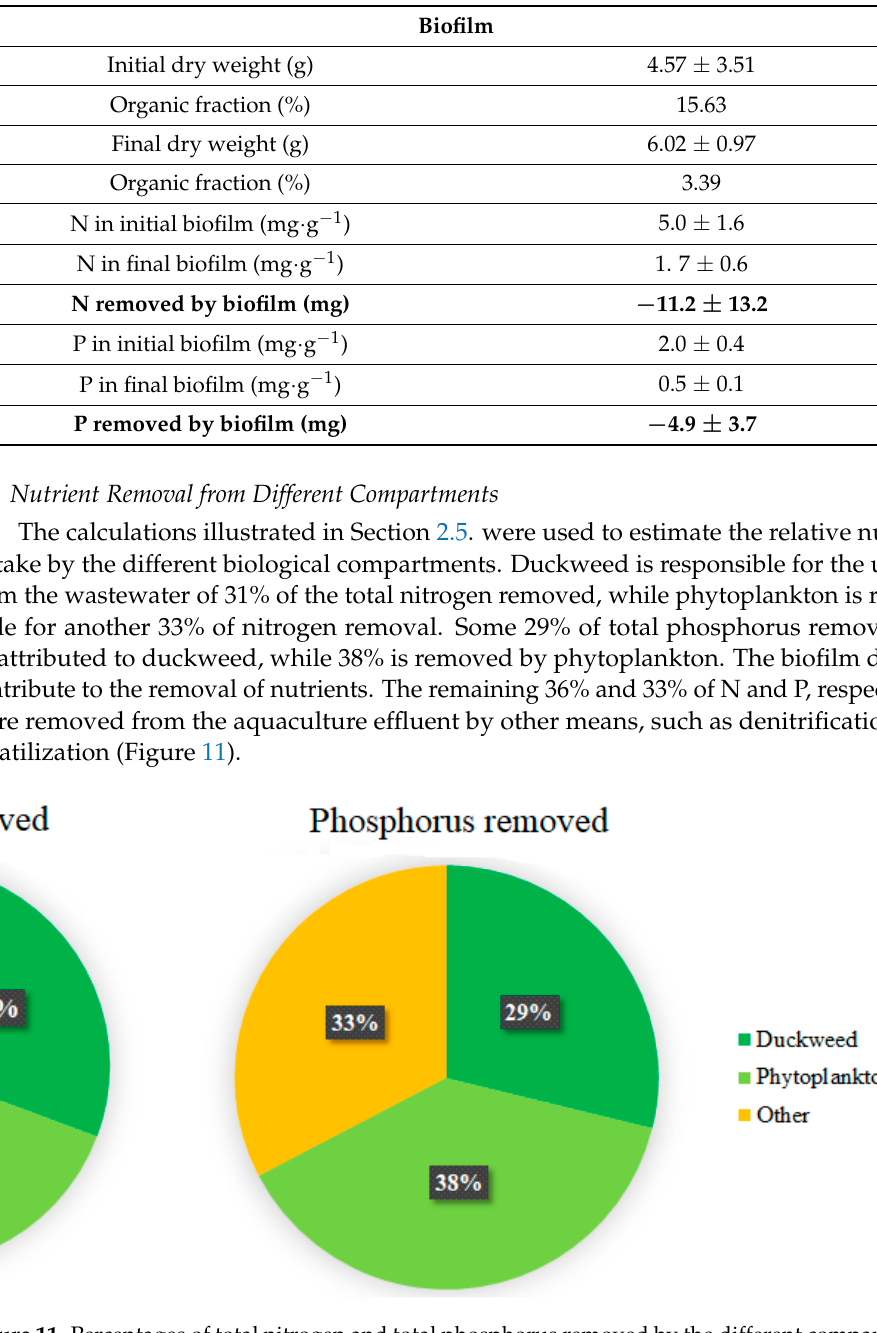
during the Figure 11. Percentages of total nitrogen and total phosphorus removed by the different compart ‐ ments during the experiment.